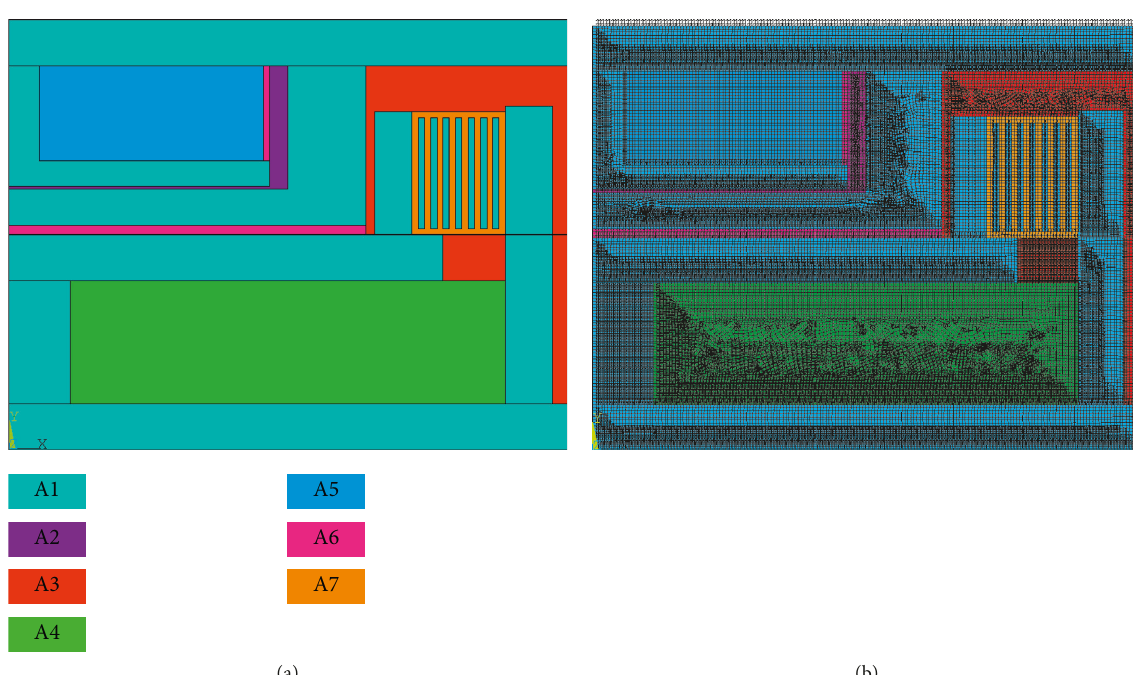
Figure 6: Finite element model of smart isolator. (a) Material partition. (b) Finite element